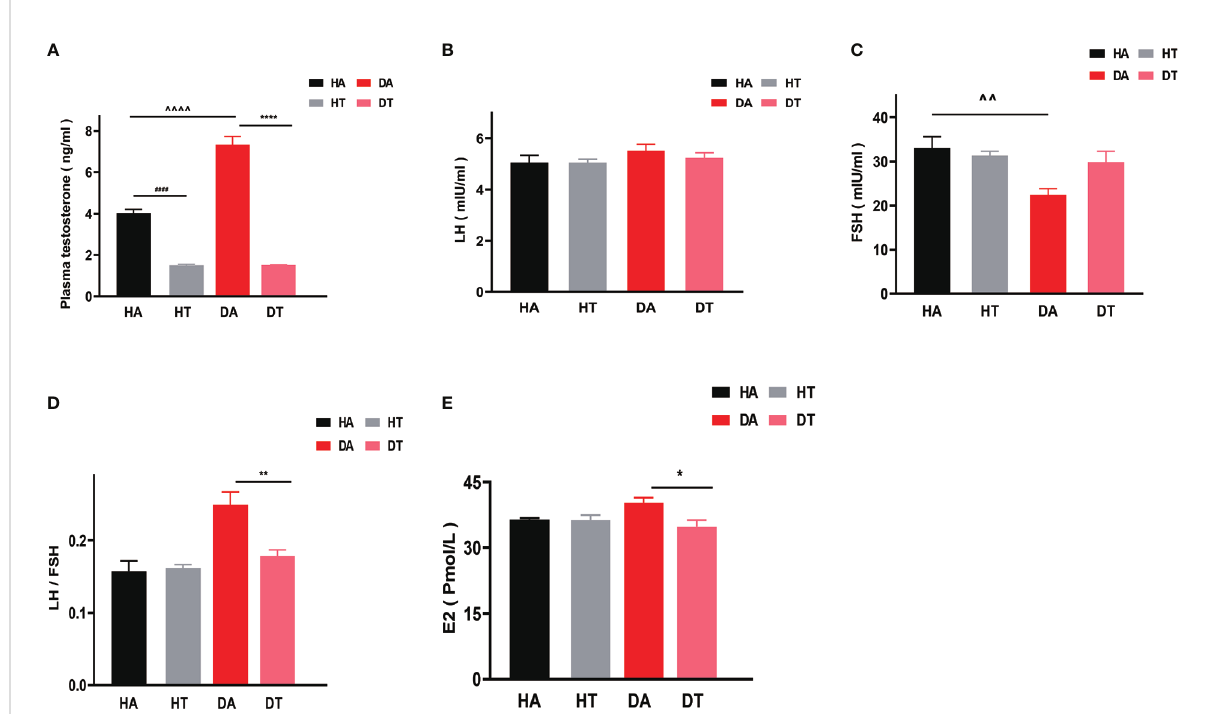
FIGURE 5 TRF ameliorates hyperandrogenemia in PCOS mice. (A) Plasma testosterone levels. (B) Plasma luteinizing hormone (LH) levels. (C) Plasma follicle-stimulating hormone (FSH) levels. (D) The ratio of LH to FSH. (E) Plasma estradiol (E2) levels. All data were presented as mean ± SEM. *P < 0.05, **P < 0.01, ****P < 0.0001, DA group vs. DT group; *P < 0.05, **P < 0.01, ****P < 0.0001, DA group vs. DT group; #### P < 0.0001, HA group vs. HT group. ^P < 0.05, ^^P < 0.01, ^^^^P < 0.0001, DA group vs. HA